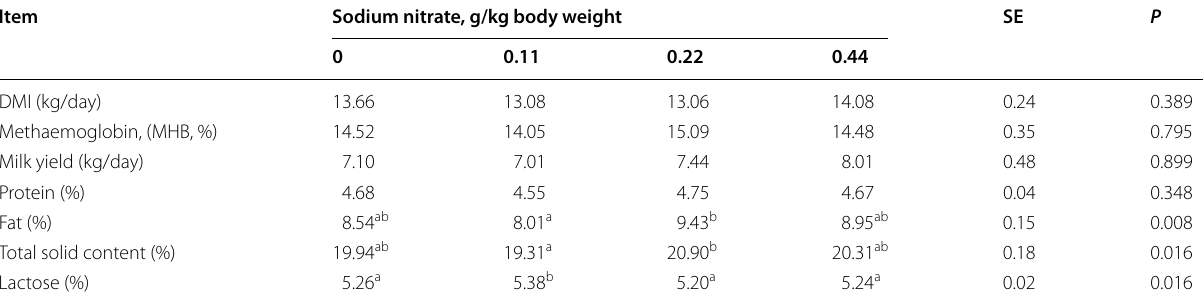
Different letters in the same row means significant differences ( P <